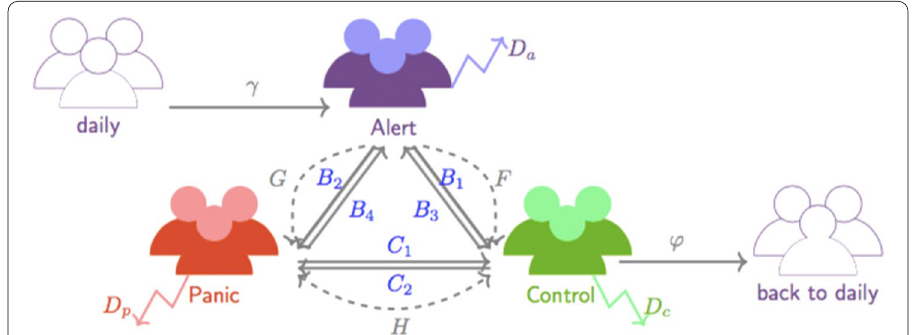
Fig. 4 Flow diagram for the APC (Alert, Panic and Control) compartment model. The intrinsic transitions are represented in solid lines, while the imitation ones in dashed